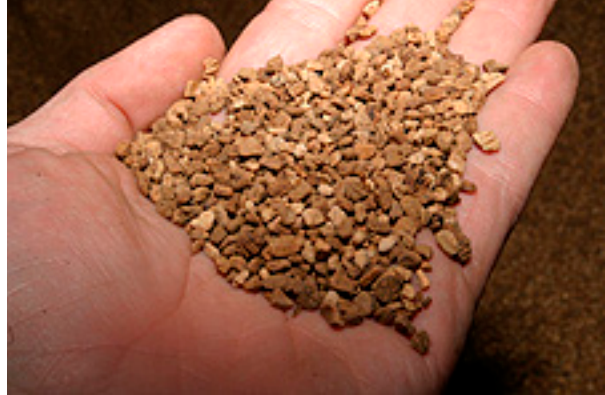
Figure 6. Endocarps from olive fruit.